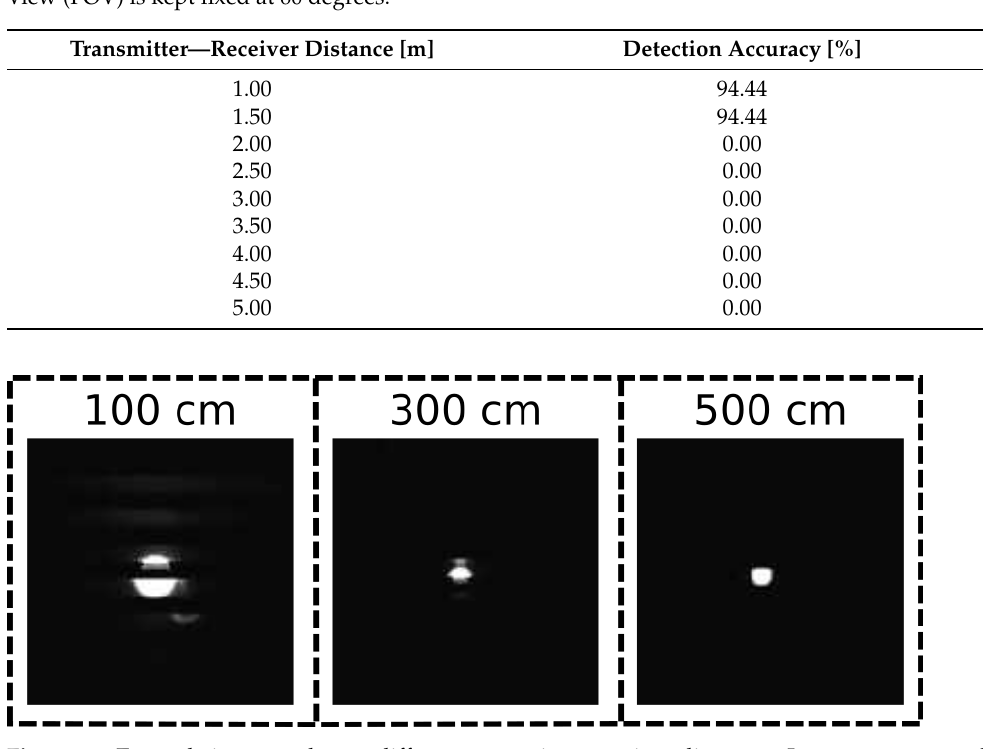
Figure 11. Example images taken at different transmitter–receiver distances. Images are cropped around the light